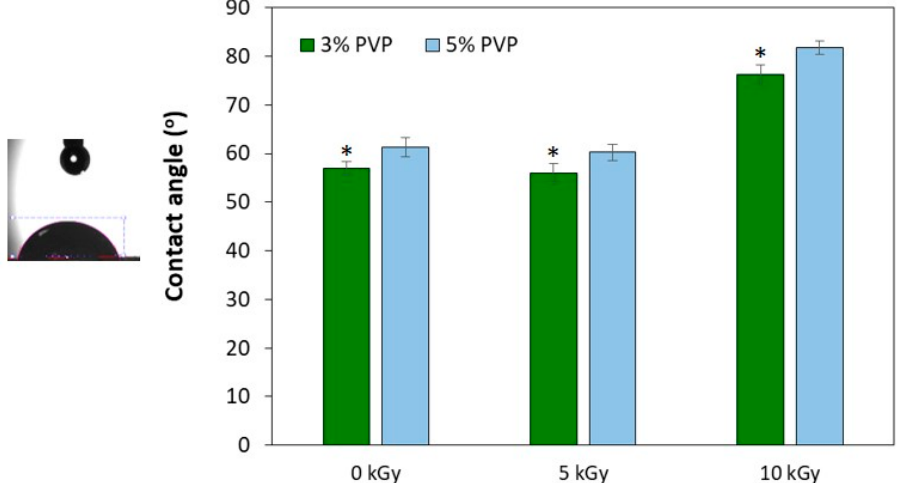
Figure 5. Contact angle of BF chitosan/PVP matrices (N 2 bubbling). Data expressed as mean ± SD ( n = 3). Contact angle does not differ significantly between radiation doses of 0 and 5 kGy (* means statistically significant with p < 0.05).